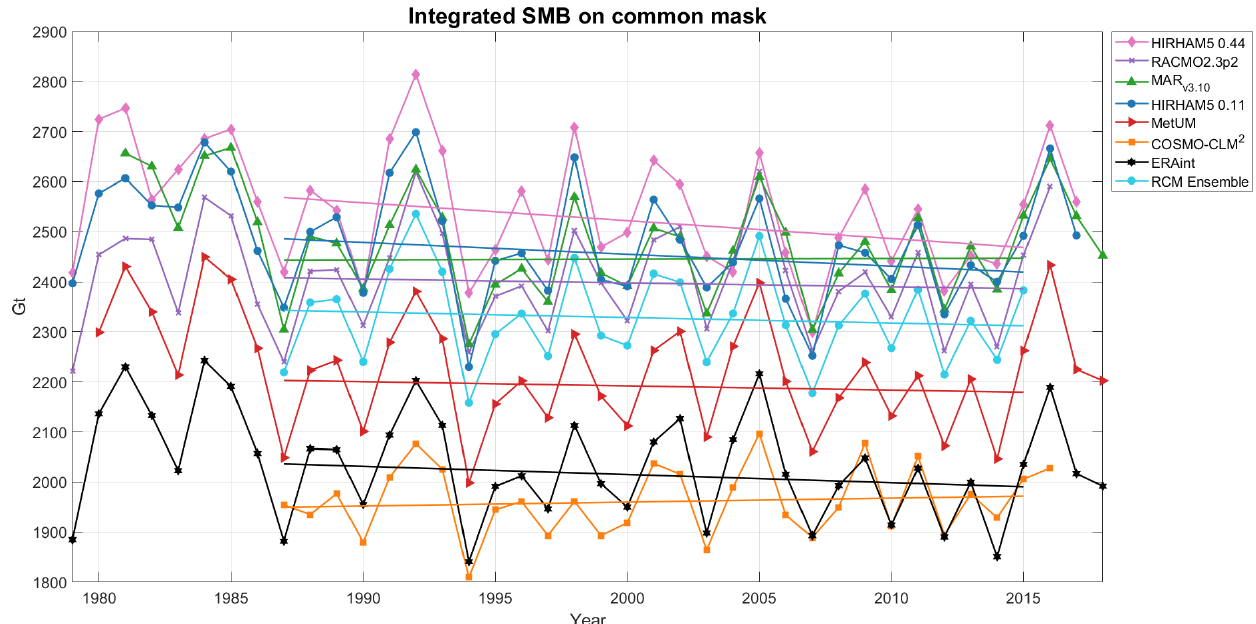
Figure 7. Annually resolved SMB integrated over the common ice mask for the different RCMs in the period 1979–2018. All RCMs are driven by ERA-Interim, and except for MAR v3.10 and RACMO2.3p2, SMB is calculated according to Eq. (1). The ensemble is a mean calculated from all six RCMs in the period 1987–2015, where there are data from all the models. All trend lines are calculated for the period